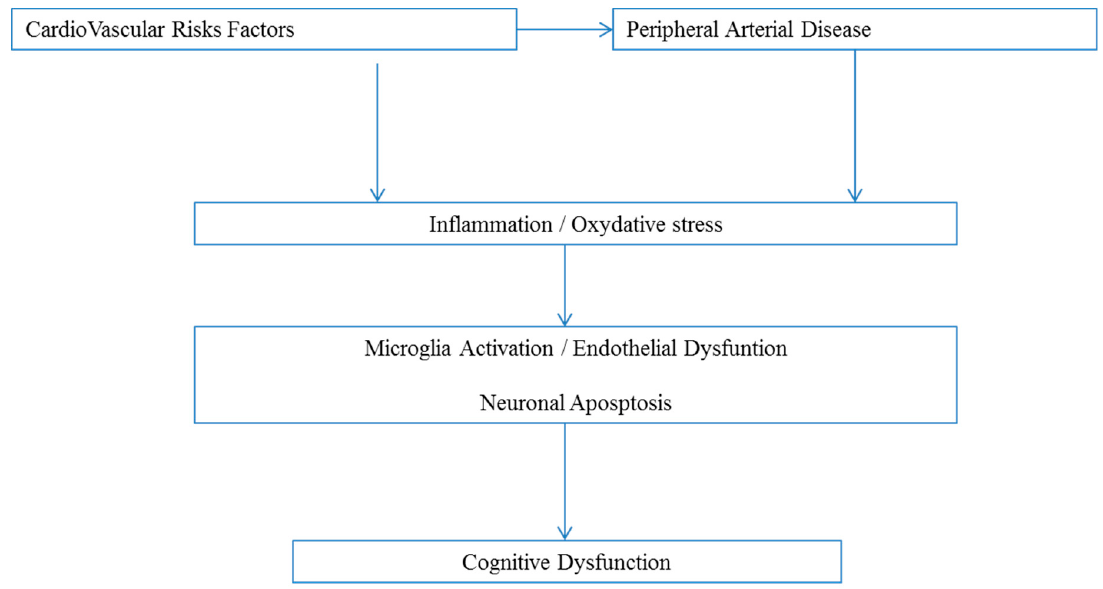
Figure 1. Mechanisms leading to cognitive dysfunction in peripheral arterial disease (PAD) patients.